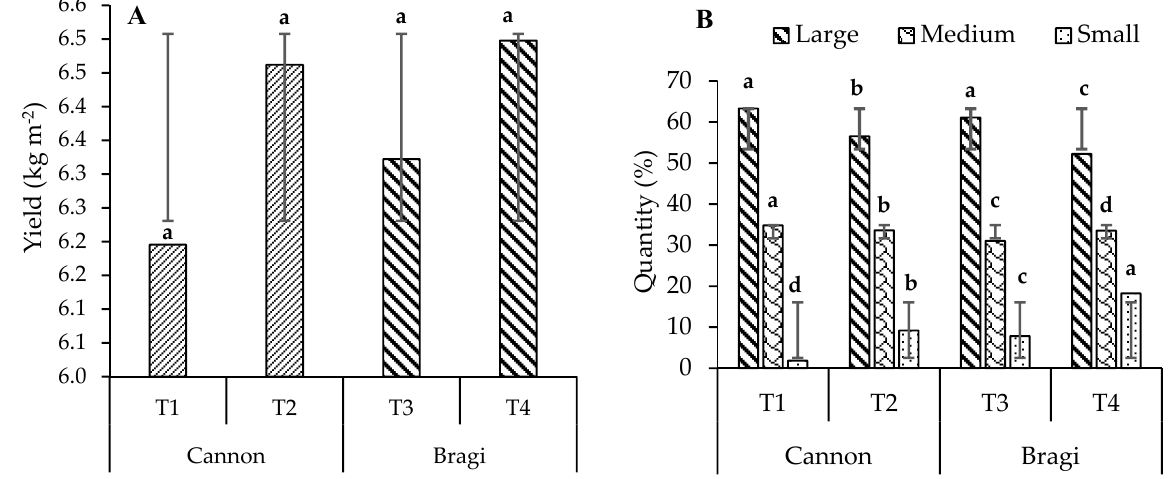
Figure 2. Yield ( A ) and size ( B ) of black pepper fruits. Different letters in each column indicate significant differences ( p ≤ 0.05).